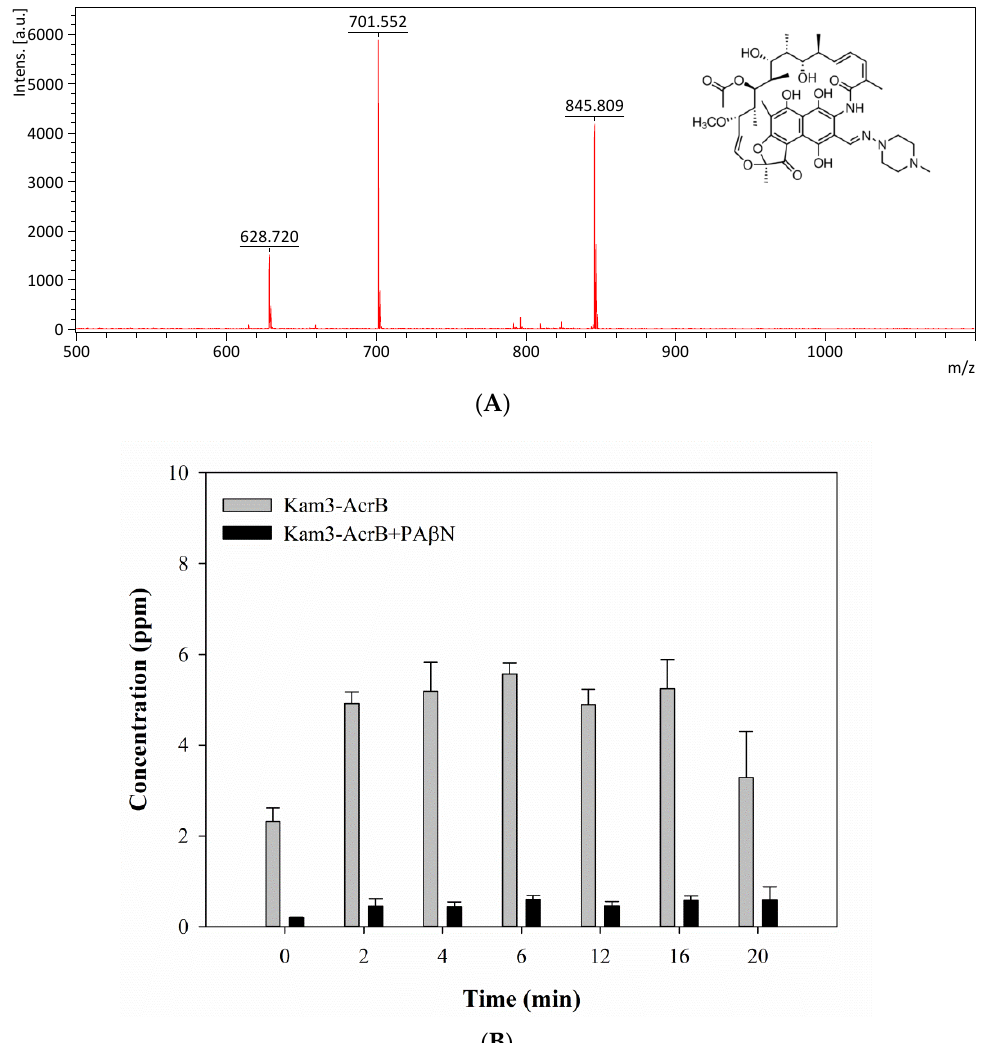
Figure 8. The rifampicin efflux activity of Kam3-AcrB was detected by using MALDI-TOF MS in the presence of modulator PAβN . ( A ) The mass spectrum of rifampicin and ( B ) the intensity of extracellular rifampicin. The intensity was plotted at the main peak at m / z 628.72, 701.55, and 845.81 of rifampicin and the detection period was 20 min. Values are expressed as mean ± standard deviation (SD) ( n = 3).